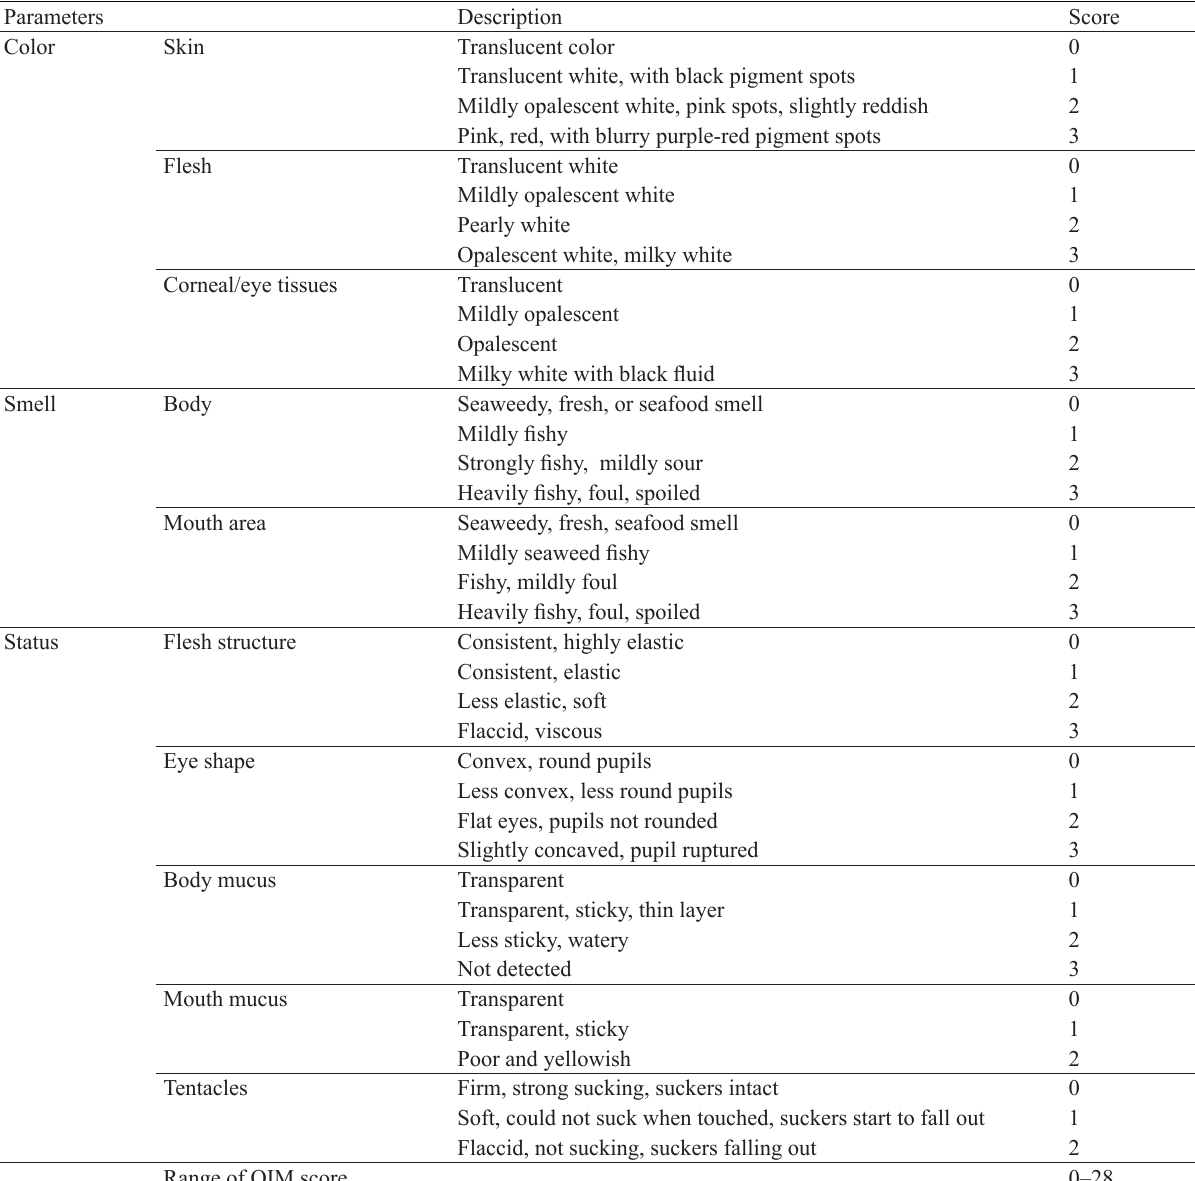
Table 1 QIM scheme for sensory evaluation of Uroteuthis (Photololigo) chinensis L.